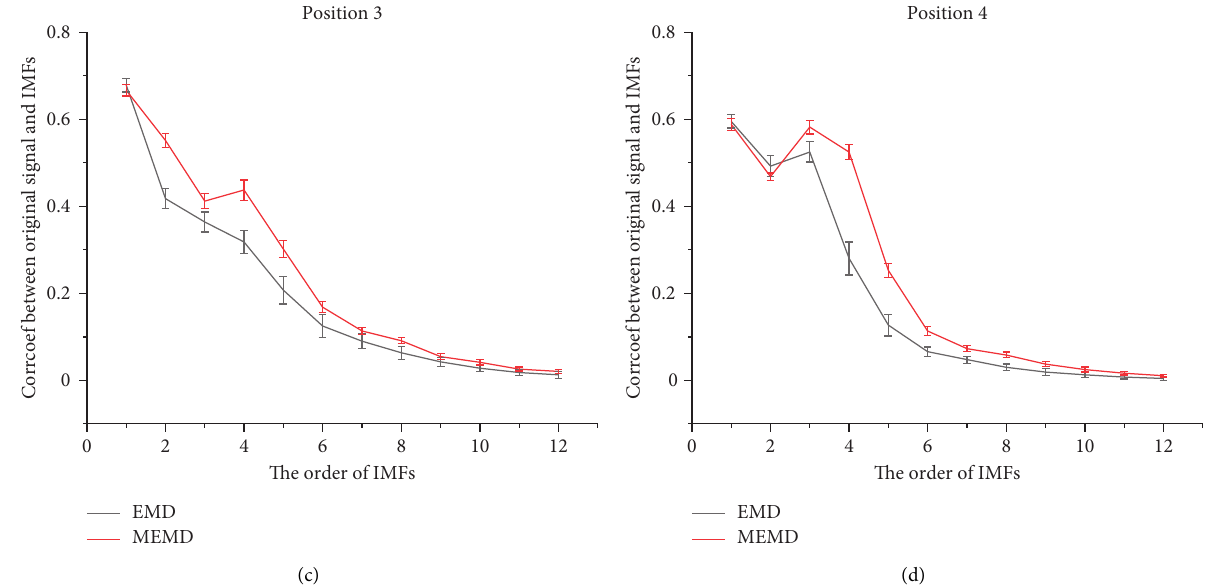
Figure 11: The correlation coefficient between original signal and IMFs (normal state).